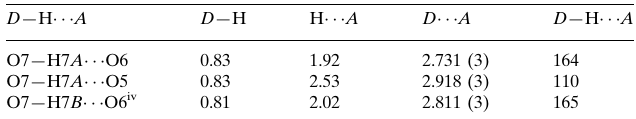
Hydrogen-bond geometry (A˚ , (cid:1)